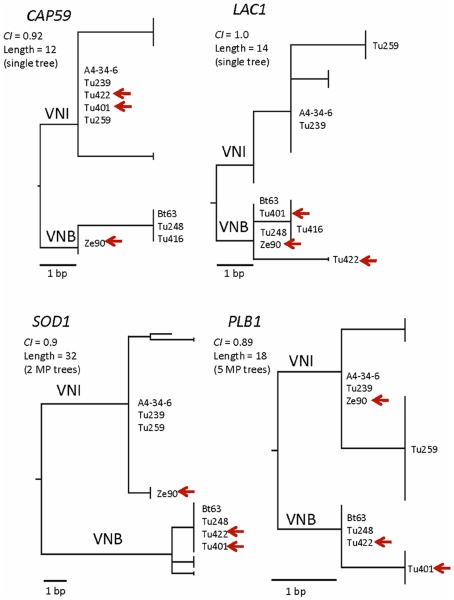
Incongruence among four gene genealogies of C. neoformans var. grubii obtained by maximum parsimony.For clarity, only representative stains are shown. The VNI and VNB subpopulations are indicated. Isolates that are inconsistently placed within the gene genealogies are marked with arrows.